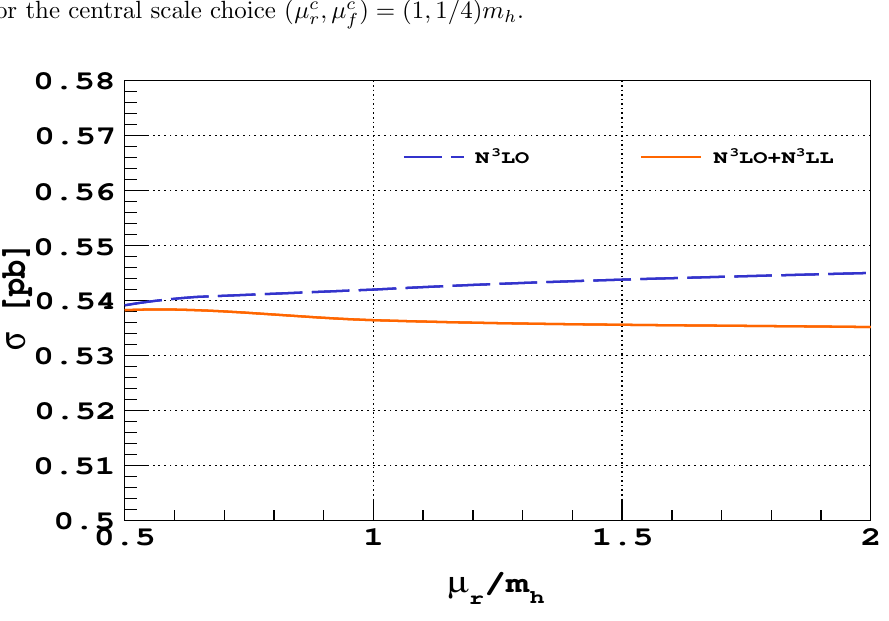
; (cid:22) c ) = (1 ; 1 = 4) m h . r f